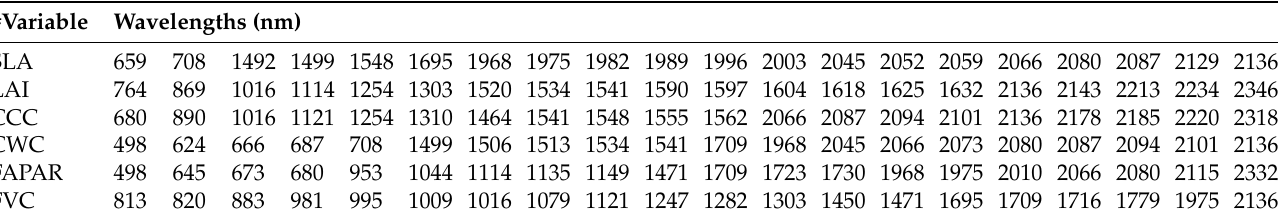
Table 4. Optimal band settings composed of the 20 best bands for each variable as identified by SBBR. Selected bands were used to build trait-specific GPR-20BR retrieval